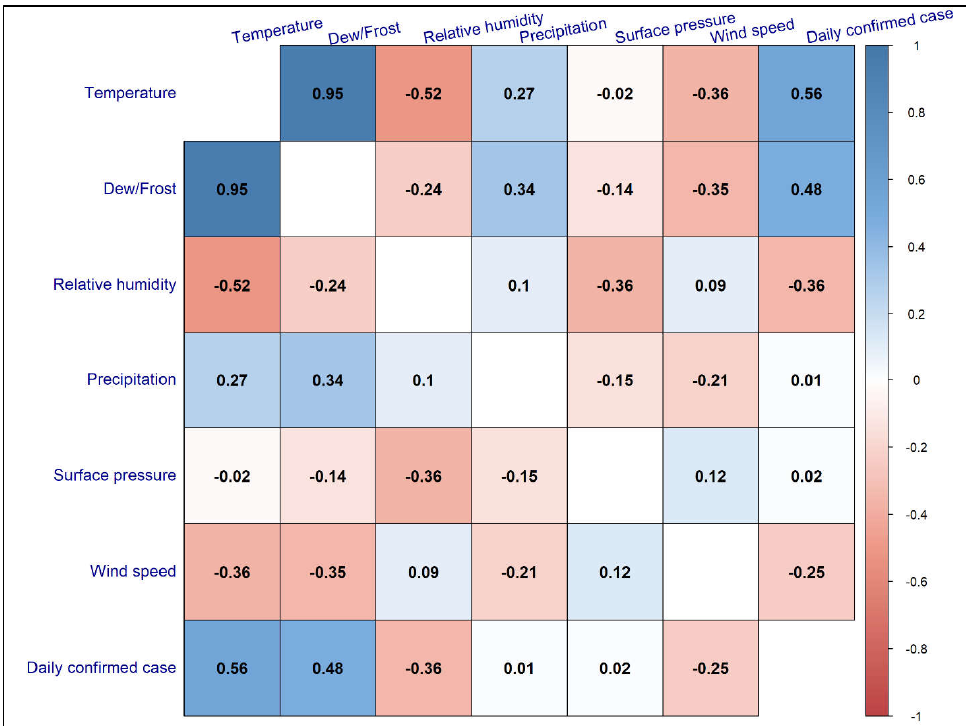
Figure 2. Spearman correlation rank coefficients between meteorological variables and confirmed global daily Monkeypox cases. Table 2. The summary of SES, ARIMA, ARIMAX, Prophet, M–K trend, and Sen’s slope analysis.